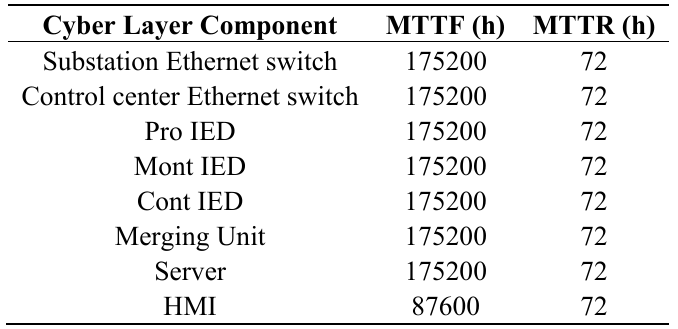
Table 1. The MTTF and MTTR of cyber layer components.